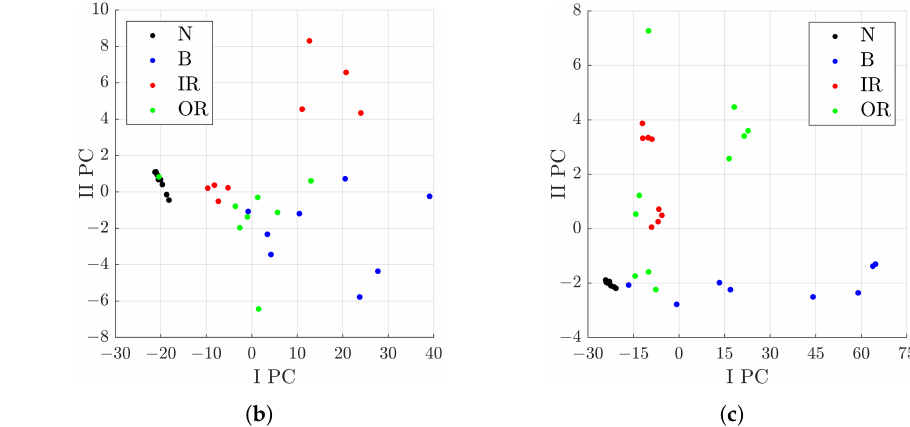
Figure 19. Distribution in the I PC–II PC plane of the analysed signals with respect to the characteris- tics selected by the Pareto method out of 11 after denoising with Group 49; ( a ) comparison of a defect dimension of 0.007 in; ( b ) comparison of a defect dimension of 0.014 in; ( c ) comparison of a defect dimension of 0.021